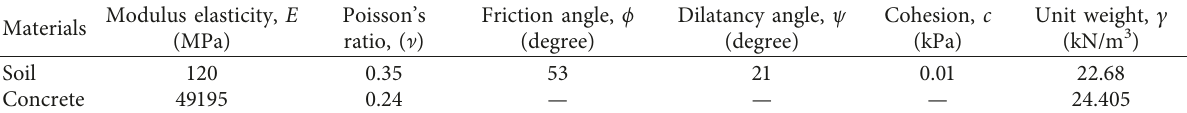
Table 1: Mechanical properties of materials [21, 22].